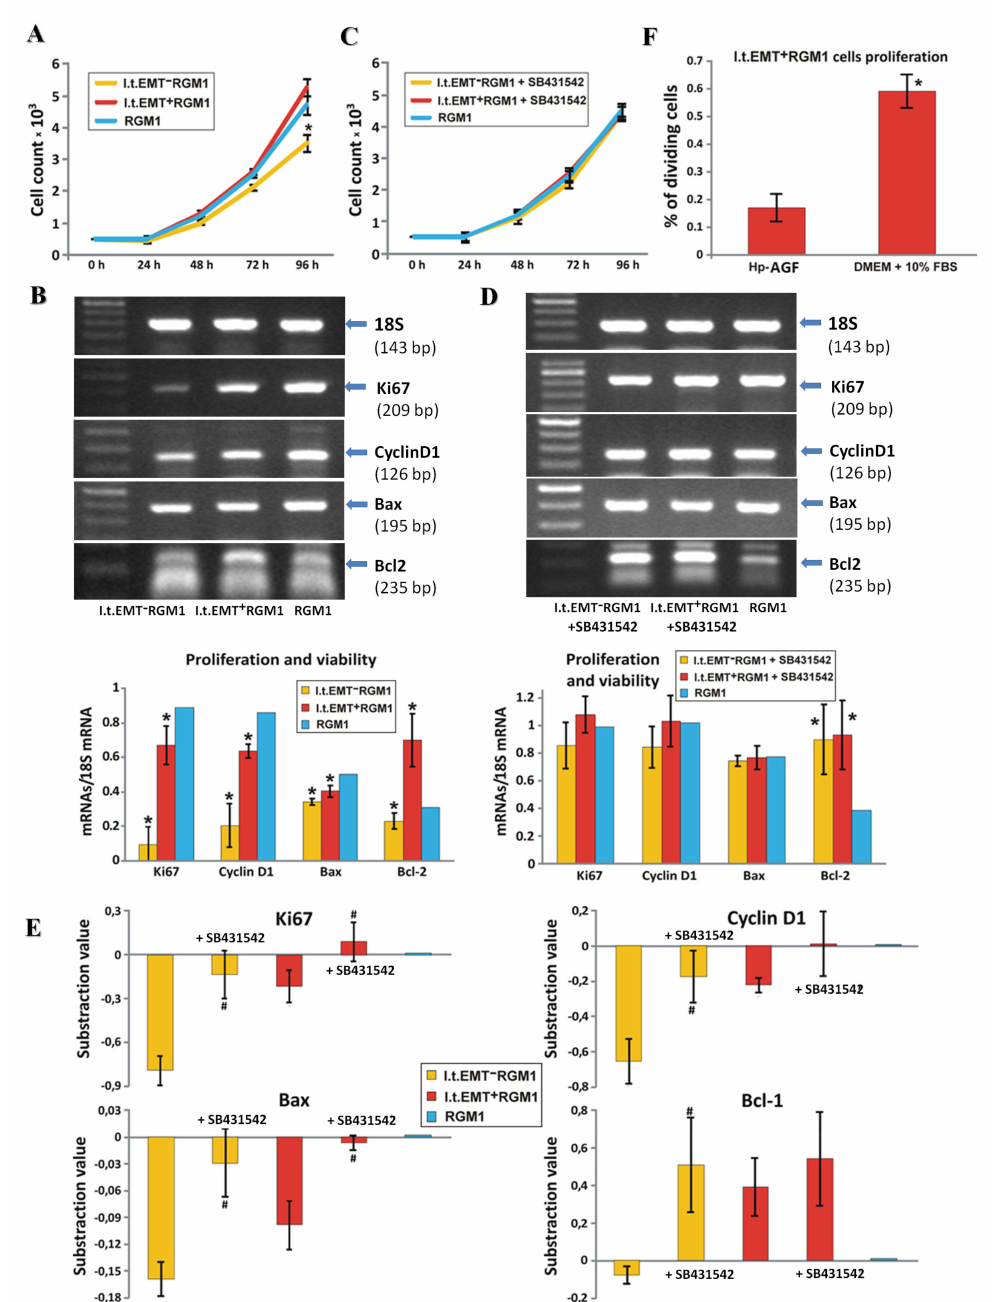
Figure 5. Hp-AGF secretome prompts TGF β -dependent proliferation of l.t.EMT + RGM1 cells. ( A ) For the proliferation assay, the l.t.EMT − RGM1 cells, l.t.EMT + RGM1 cells, and original RGM1 cells were seeded onto 24-well plates (0.5 × 10 3 cells / cm 2 ) in corresponding media. After 24, 48, 72, and 96 h, the cells were harvested, stained with trypan blue, and counted with Bürker’s hemocytometer. ( B ) RT-PCR analysis of the expression of 18S mRNA and a panel of prosurvival and pro-proliferative factor mRNA expression in l.t.EMT − RGM1 cells, l.t.EMT + RGM1 cells, and original RGM1 cells and the ratio of selected genes over 18S mRNA. ( C ) The influence of TGF β R1 signaling on cell proliferation was checked by the addition of 10 µ M of TGF β R1 kinase activity receptor inhibitor SB-431542 to the l.t.EMT − RGM1 and l.t.EMT + RGM1 cells. As a reference, RGM1 cells cultured in DMEM + 10% FBS were used. ( D ) RT-PCR analysis of TGF β R1 signaling dependence of 18S mRNA and of prosurvival and pro-proliferative factors’ mRNA expression in the presence of SB-431542. ( E ) The overall analysis of proliferative and prosurvival factor expression with and without SB-431542 in relation to the control value which